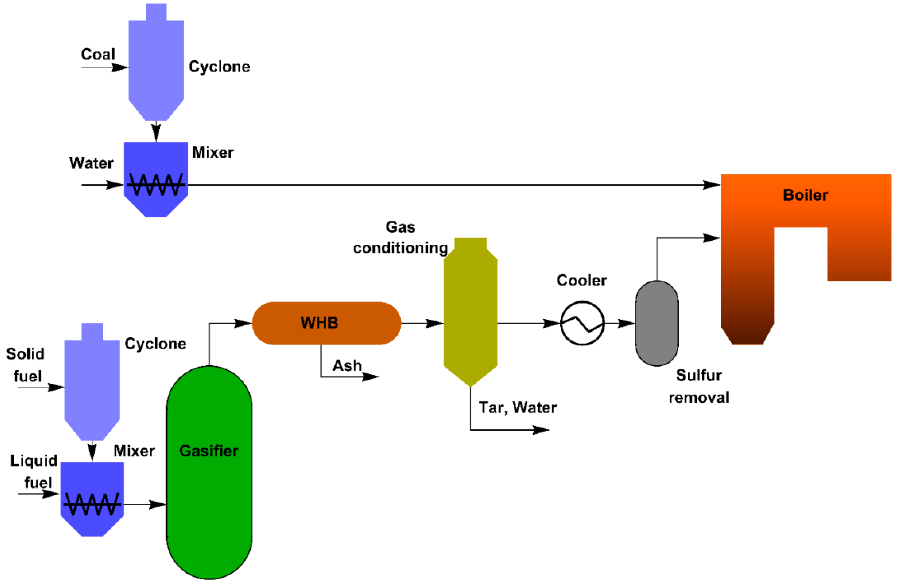
Figure 7. Technological process scheme of CWS flaring while adding syngas to the boiler furnace.